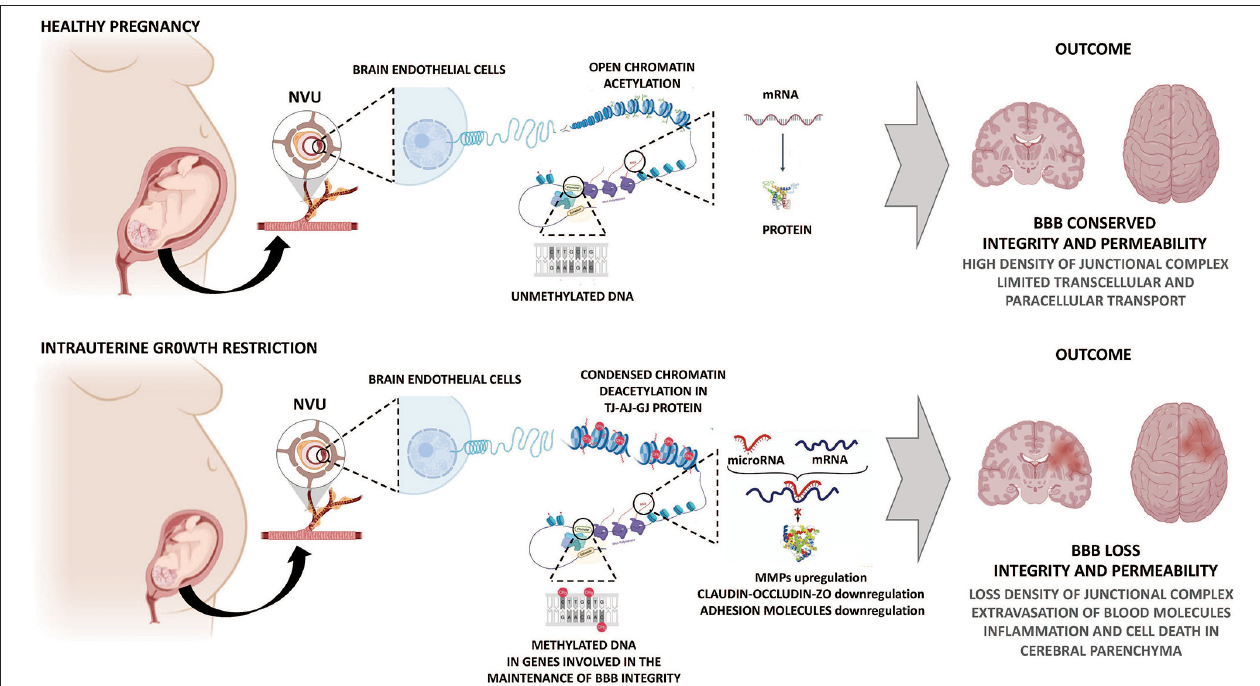
FIGURE 2 | Potential epigenetic mechanisms determining impairment of the BBB permeability by gestational hypoxia. Hypoxic and IUGR injury causes a series of molecular events, including programming of BBB through genomic DNA methylation signature and an altered expression of microRNAs. These mechanisms contribute to changes in the expression of molecules related to junctional complexes of the BBB, increasing BBB permeability and further brain damage. AJ, adherens junction; BBB, blood-brain barrier; GJ, gap junction; MMPs: metalloproteinases; NVU, neurovascular unit; TJ, tight junction; ZO, zonula